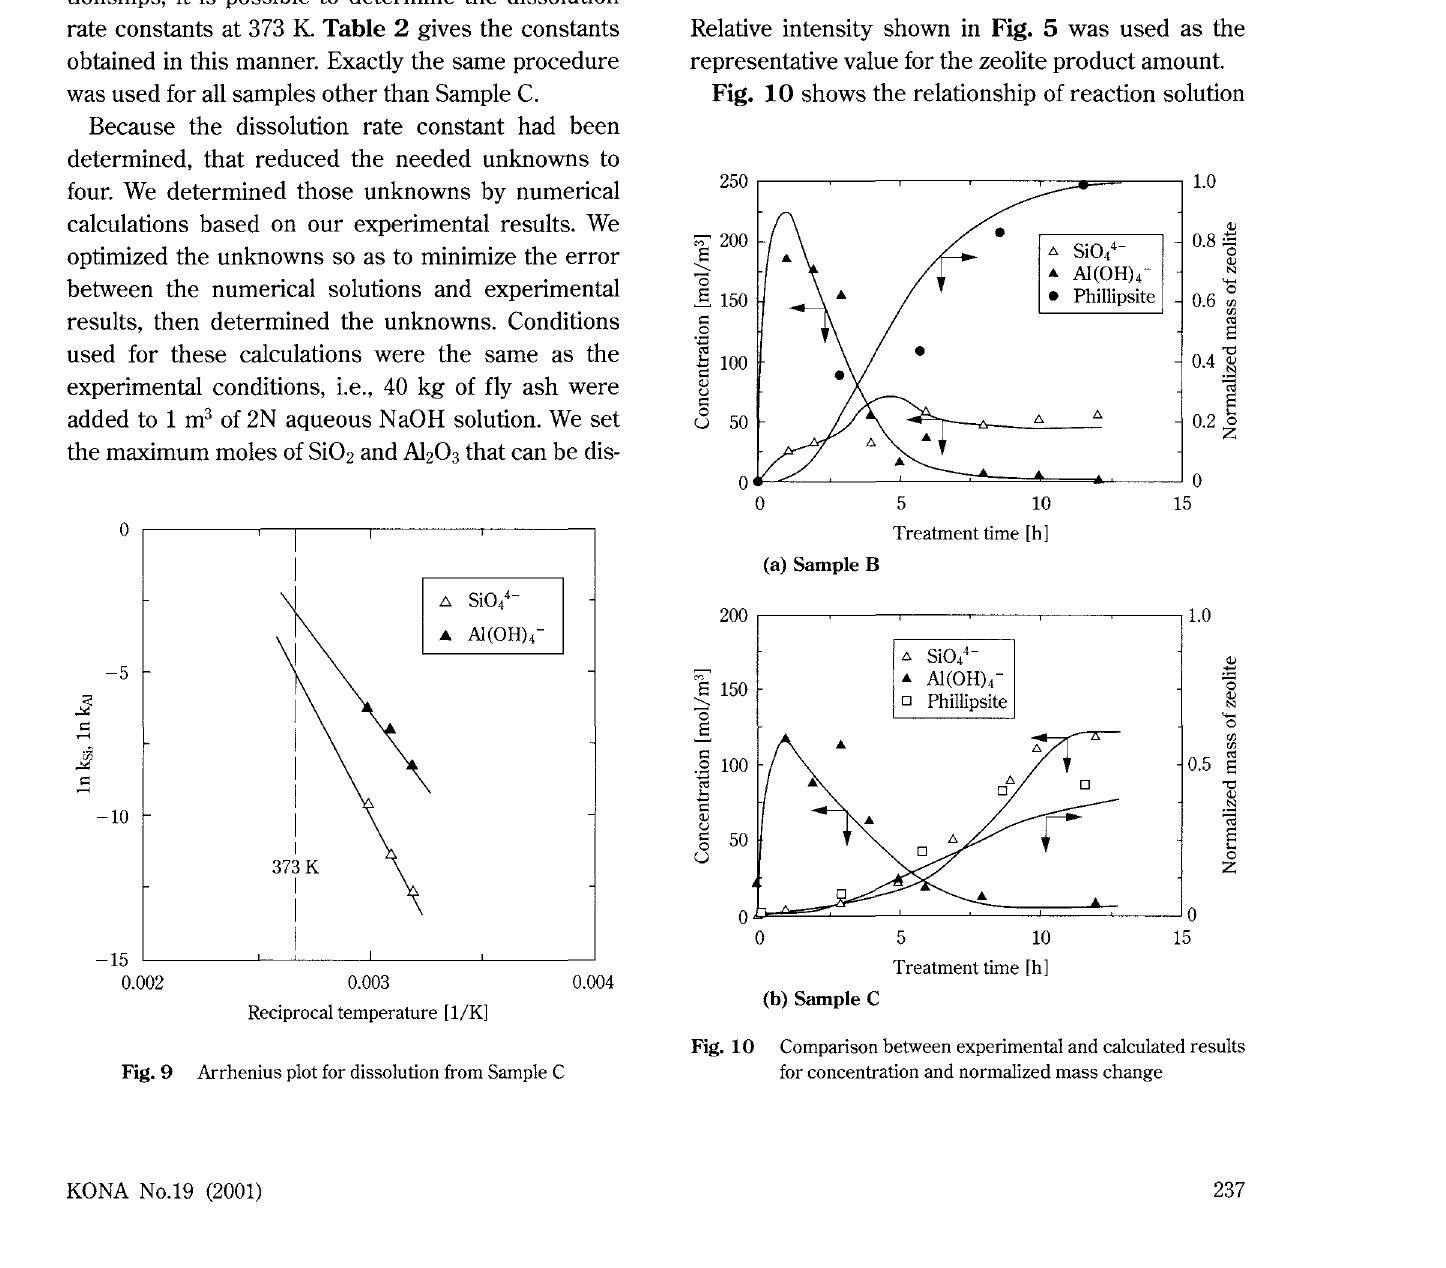
KONA No.19 (2001)